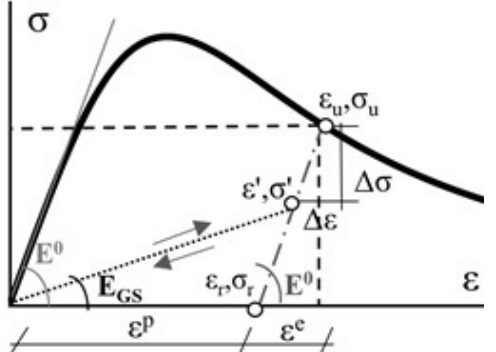
Figure 3. Linear elastic